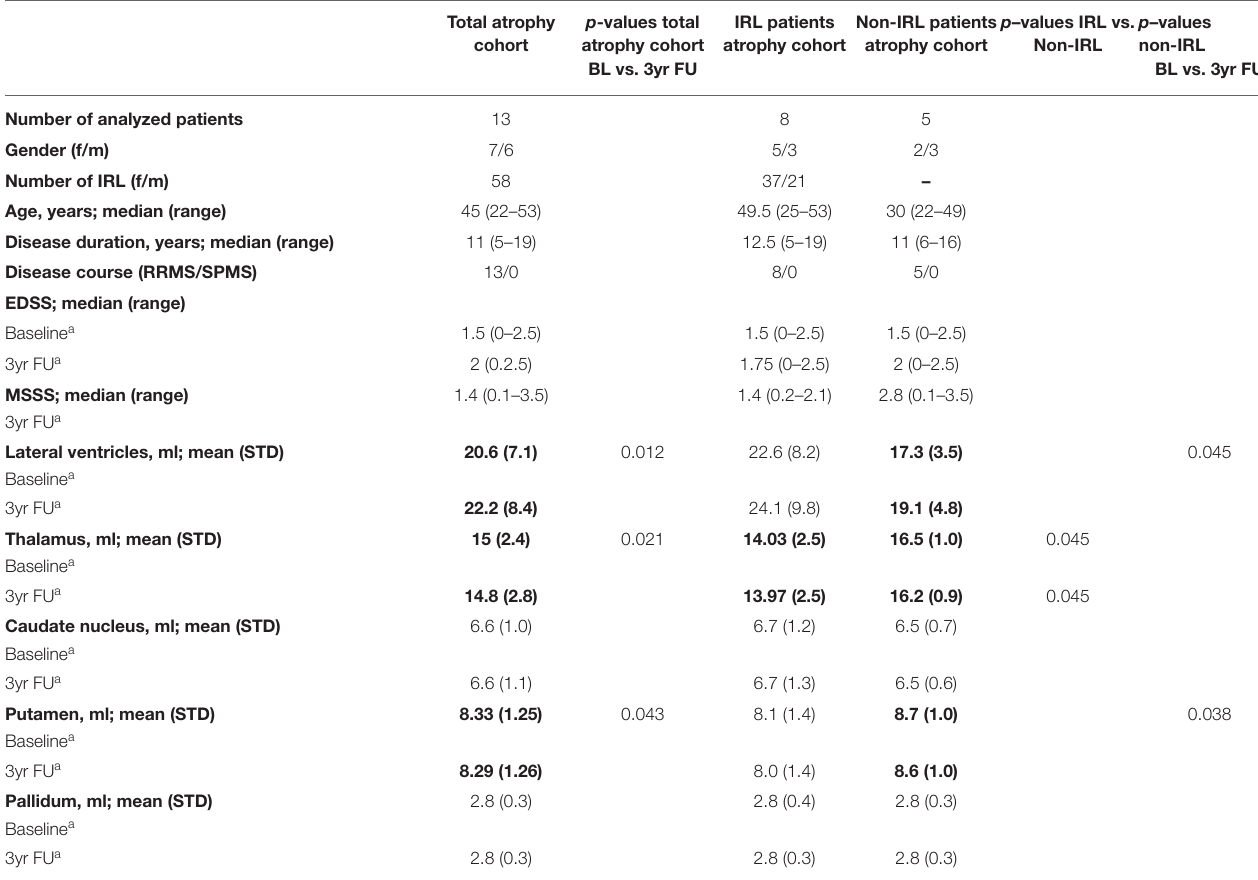
TABLE 2 | Demographic, clinical, and MRI data of the atrophy